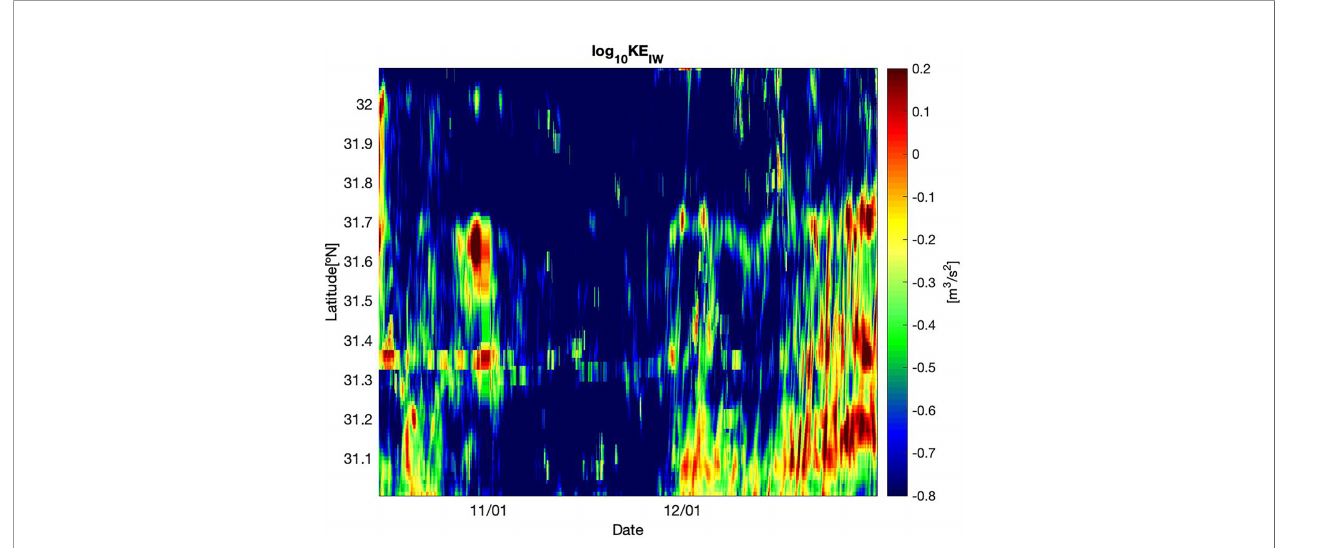
FIGURE 9 | Hovmoeller plot of internal wave kinetic energy integrated over 200 m depth (m 3 s -2 ) and averaged zonally over the continental shelf, where depth is less than 200 m depth, as a function of latitude and time.